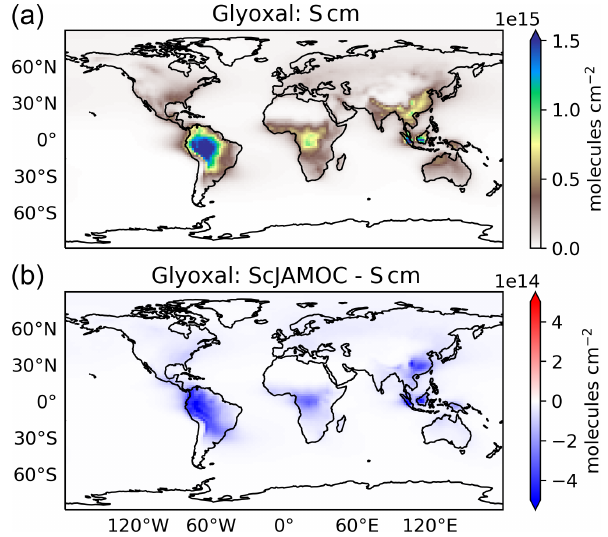
Figure 5. Mean integrated tropospheric glyoxal column for Scm (a) and in comparison to ScJAMOC (b) . The characteristics of each simulation are provided in Table